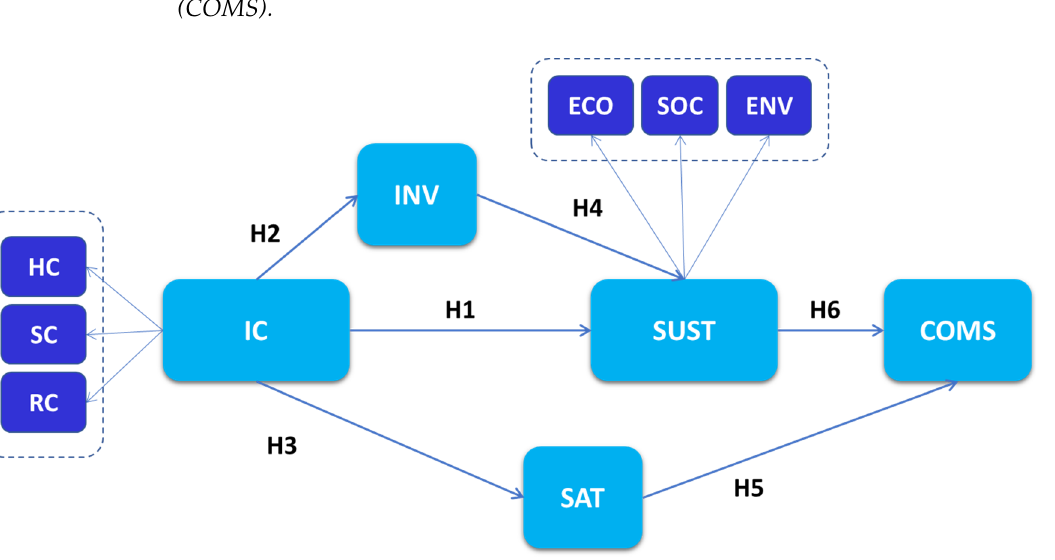
Figure 1. Conceptual model Source: prepared by the authors. The methodological choices of the study are explained